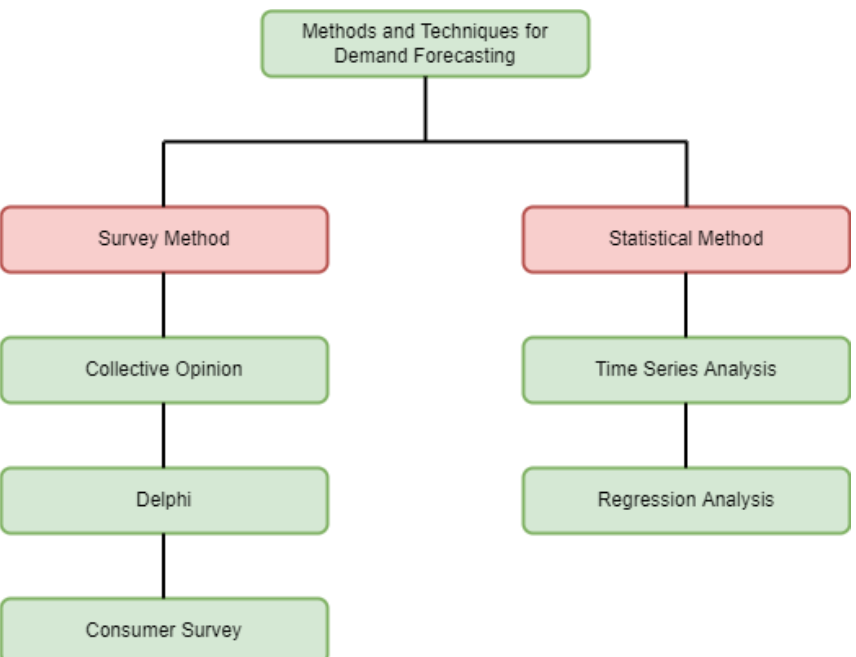
Figure 5. Methods and techniques for energy demand